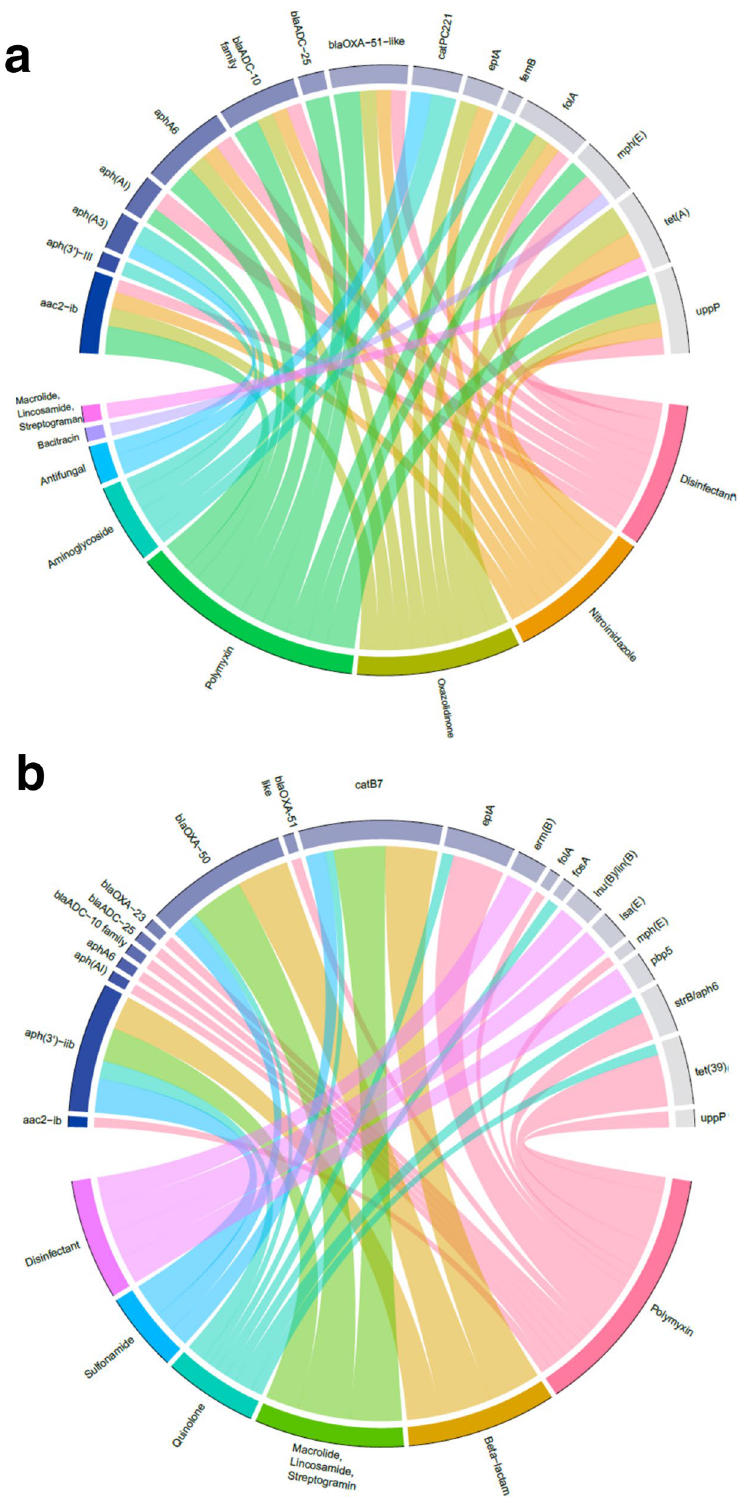
Figure 5. Association between antimicrobial treatment regimen and detection of antimicrobial resistance gene signatures in wound effluent samples. Mutual information analysis was applied to compare detection of genomic signatures for antimicrobial resistance with drug classes administered. Detection of resistance gene signatures is shown in samples obtained from both ( a ) healed and ( b ) failed wounds, to examine distinctions in associations across these patient